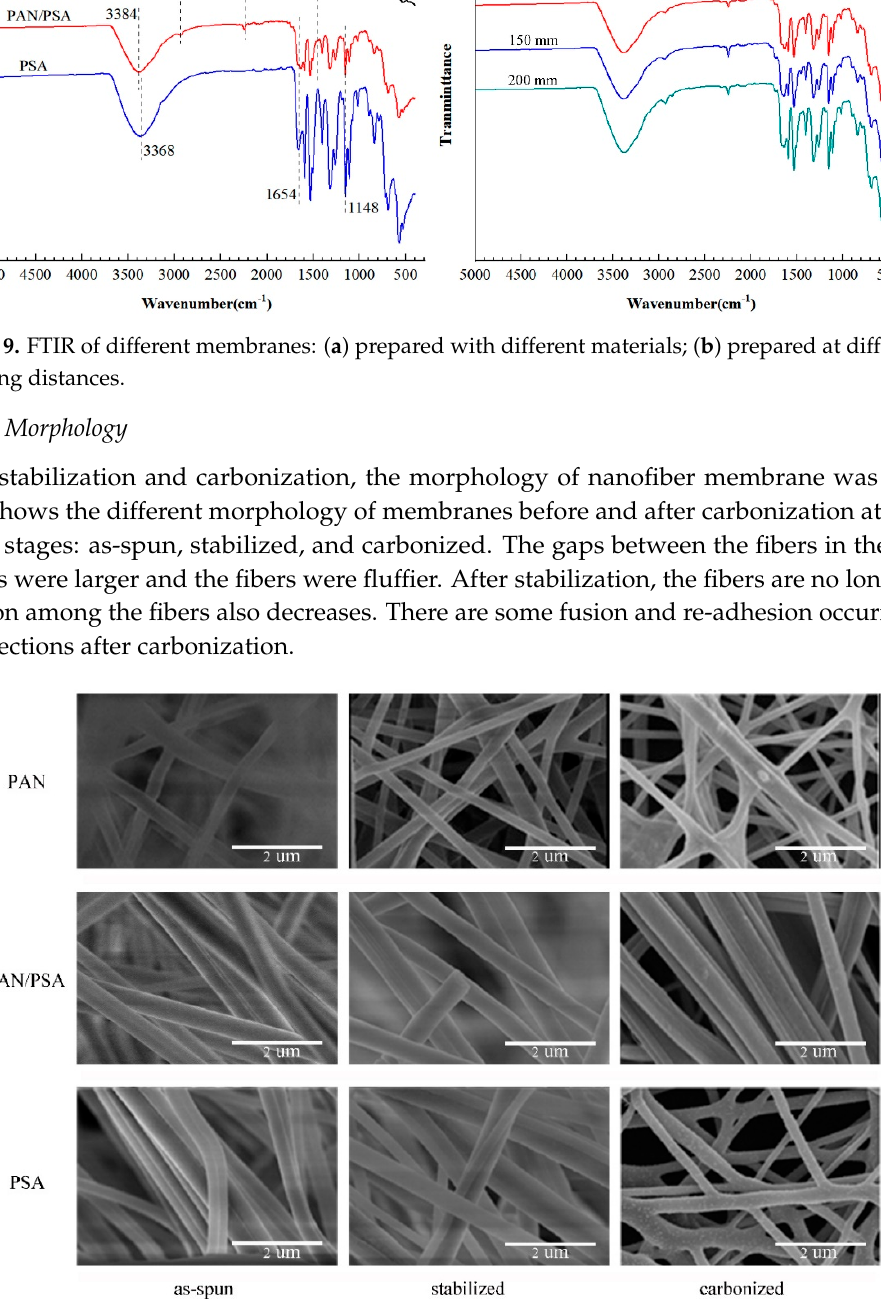
Figure 9. FTIR of different membranes: ( a ) prepared with different materials; ( b ) prepared at different receiving distances.